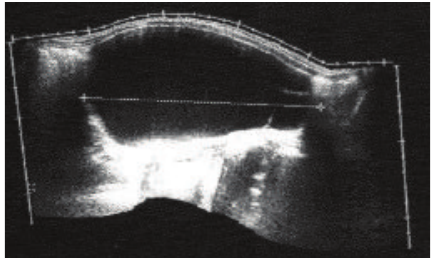
Figure 2: Abdominal ultrasound showing a 14cm by 7cm by 12cm fluid filled structure in the left half of the abdomen.